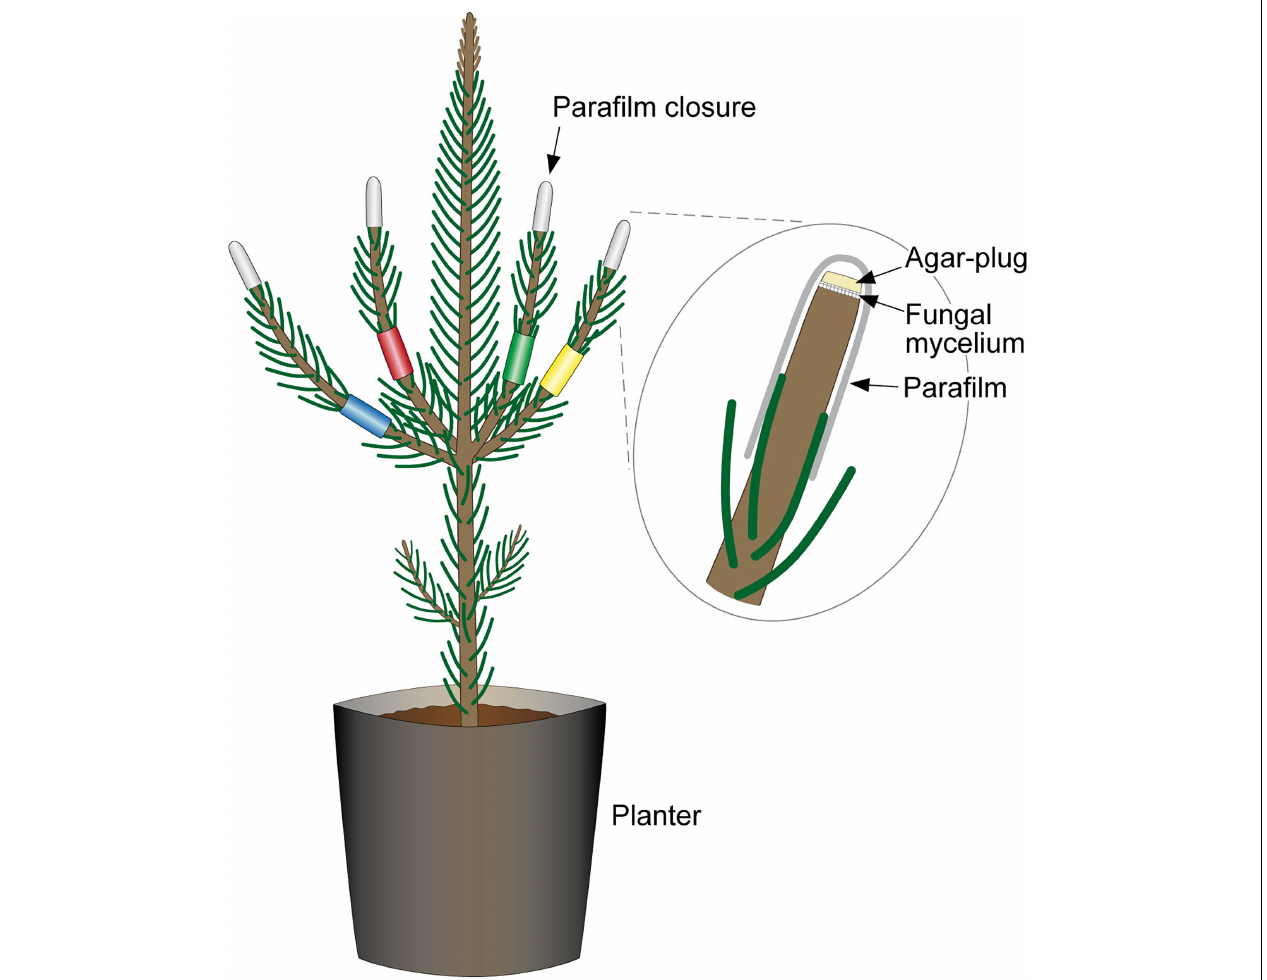
FIGURE 3 | Combined-infection of pine seedlings. Each of the side-shoots is color-labeled to indicate the different fungal strains with which pine was infected. The labeling allowed differentiation during necrosis measurements and re-isolations. Excised tips were replaced with a mycelium-covered agar plug and were sealed with Parafilm R (cid:13)